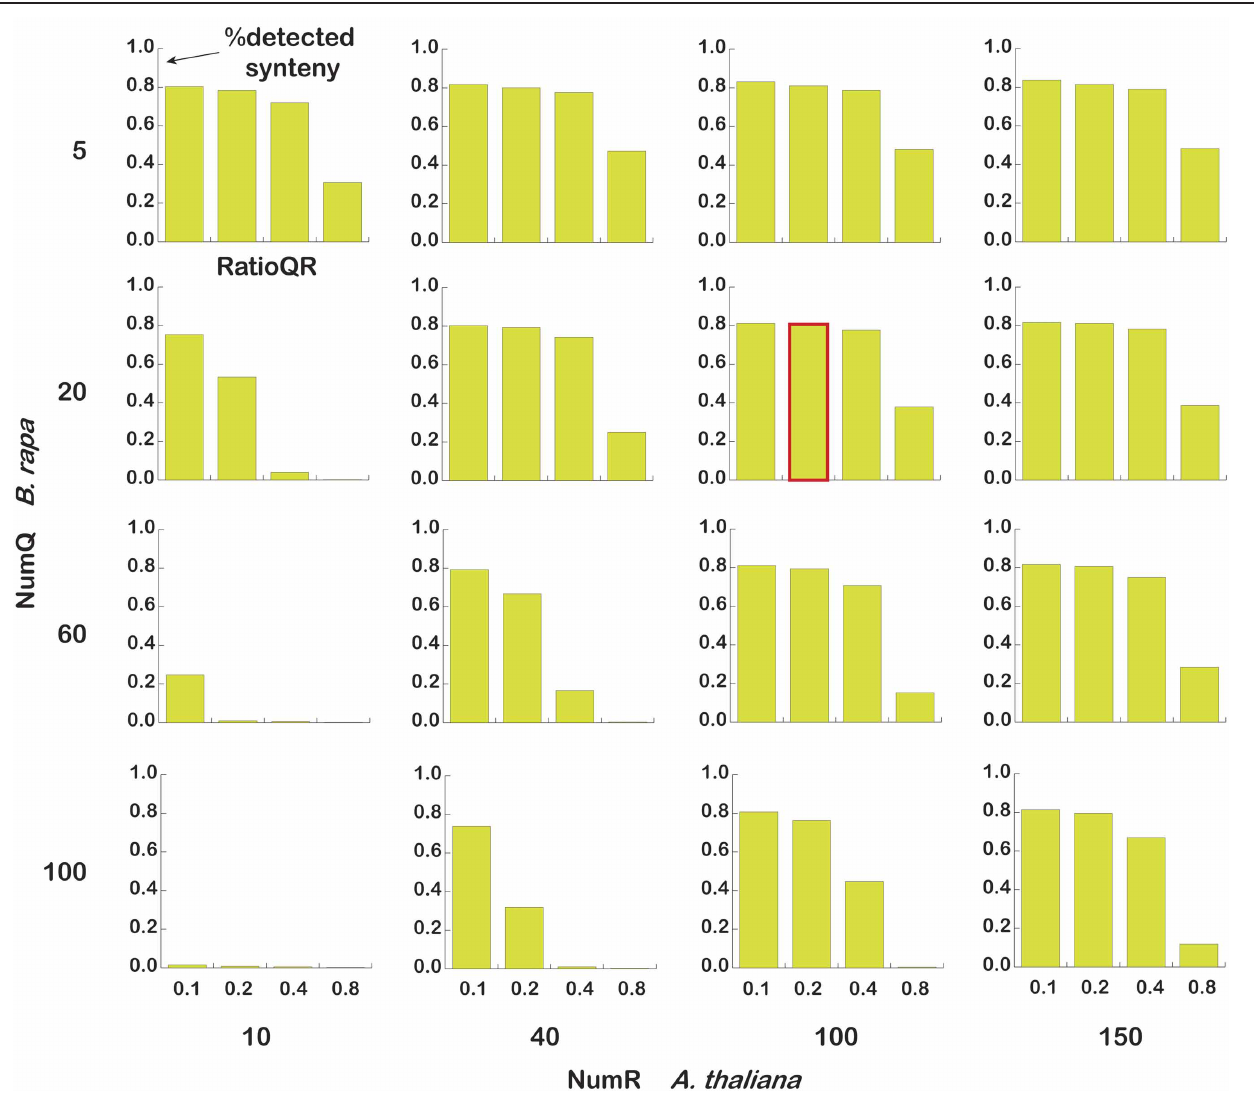
FIGURE 2 | Parameter estimation in SynOrths. The number of query ( B. rapa ) flanking genes [5, 20, 60, 100], the number of reference ( A. thaliana ) flanking genes [10, 40, 100, 150], and the threshold of the flanking genes’ support ratio [0.1, 0.2, 0.4, 0.8] were set to run SynOrths. The bars indicate the proportions of syntenic genes identified out of 38,161